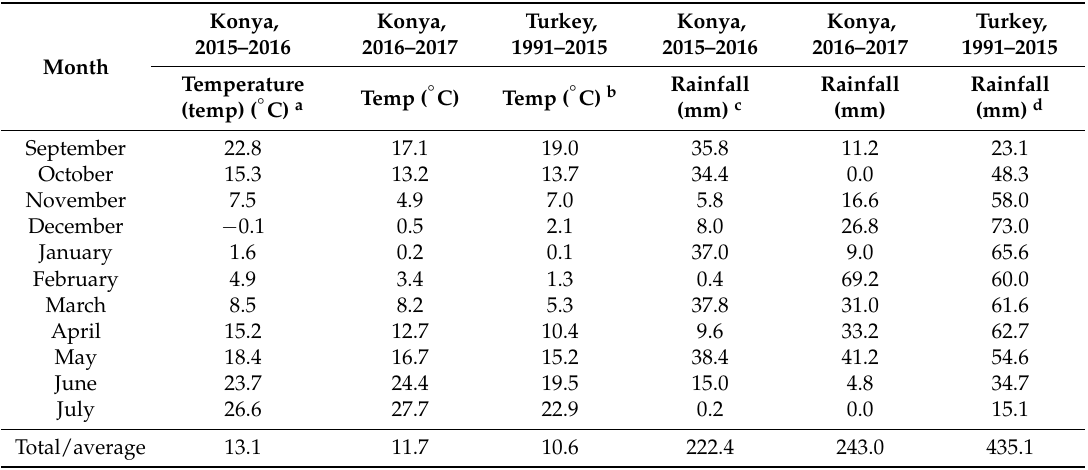
Table 1. Mean monthly temperatures and total monthly rainfalls in two growing seasons (2016 and 2017) and 25-year averaged data in Konya, Turkey.